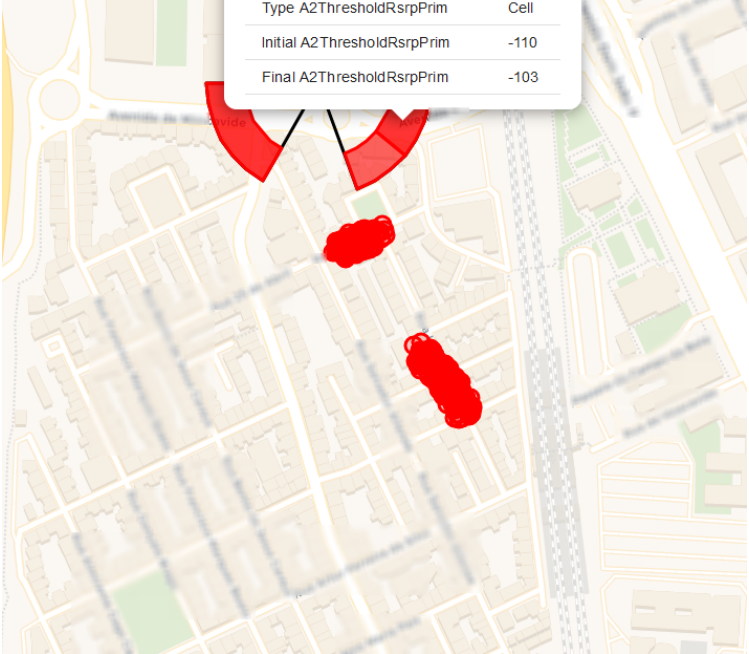
Figure 21. Inter-frequency handover optimization algorithm